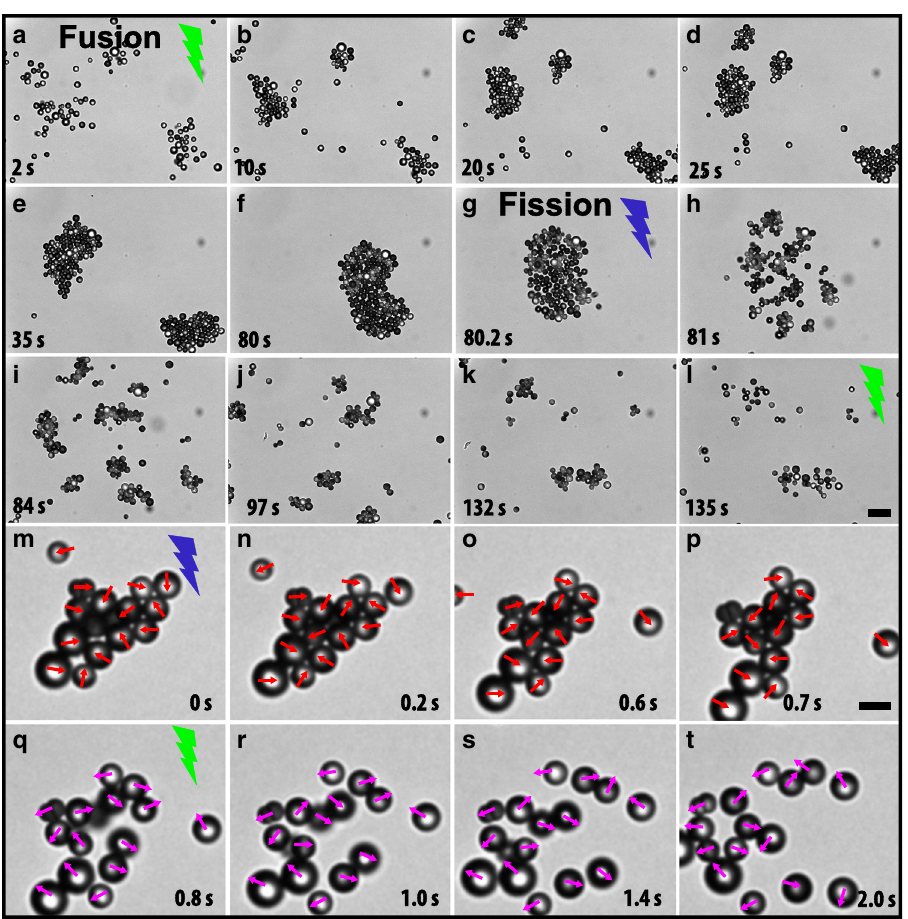
Fig. 2 Fusion and fi ssion dynamics of switchable photoresponsive colloids. a – f Fusion: Time-evolution and dynamic growth show the fusion of the active particles into a single cluster. g – k Fission: Time-evolution of the fi ssion dynamics shows the big cluster under the UV illumination. This single cluster explodes into small clusters when the direction of propulsion of the particle is reversed. l Small clusters dissolve when the illumination switches to green light. Colour of lightning bolt shows the wavelength of light used in the experiment. m - t Projected orientations of the caps reveal the self-trapping of the particles in a cluster, and the melting of the cluster when the propulsion direction is reversed. m – p Red colour arrow points the propulsion direction along the TiO 2 side, bright side of the particle. q – t Magenta colour arrow depicts the propulsion direction reversal under green or high-intensity white light illumination. Scale bar is 5.0 μ